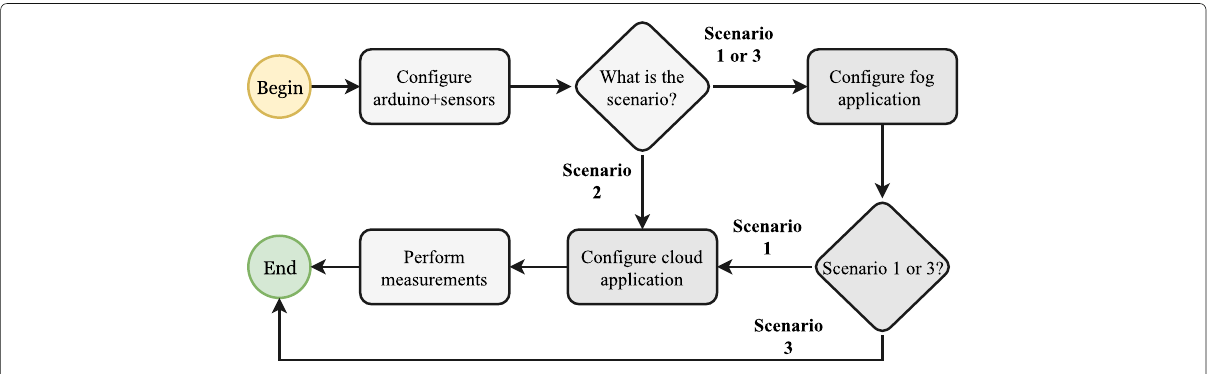
Fig. 11 Methodology for configuring devices according to each scenario